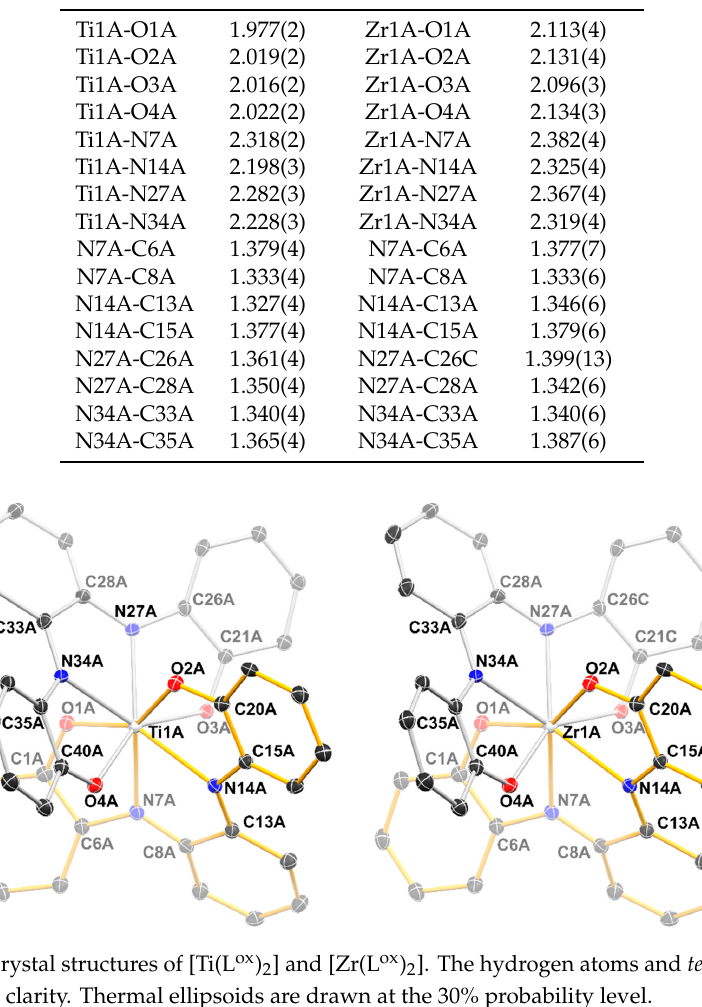
Table 1. Selected bond lengths (Å) for [Ti(L ox )2] and [Zr(L ox )2].